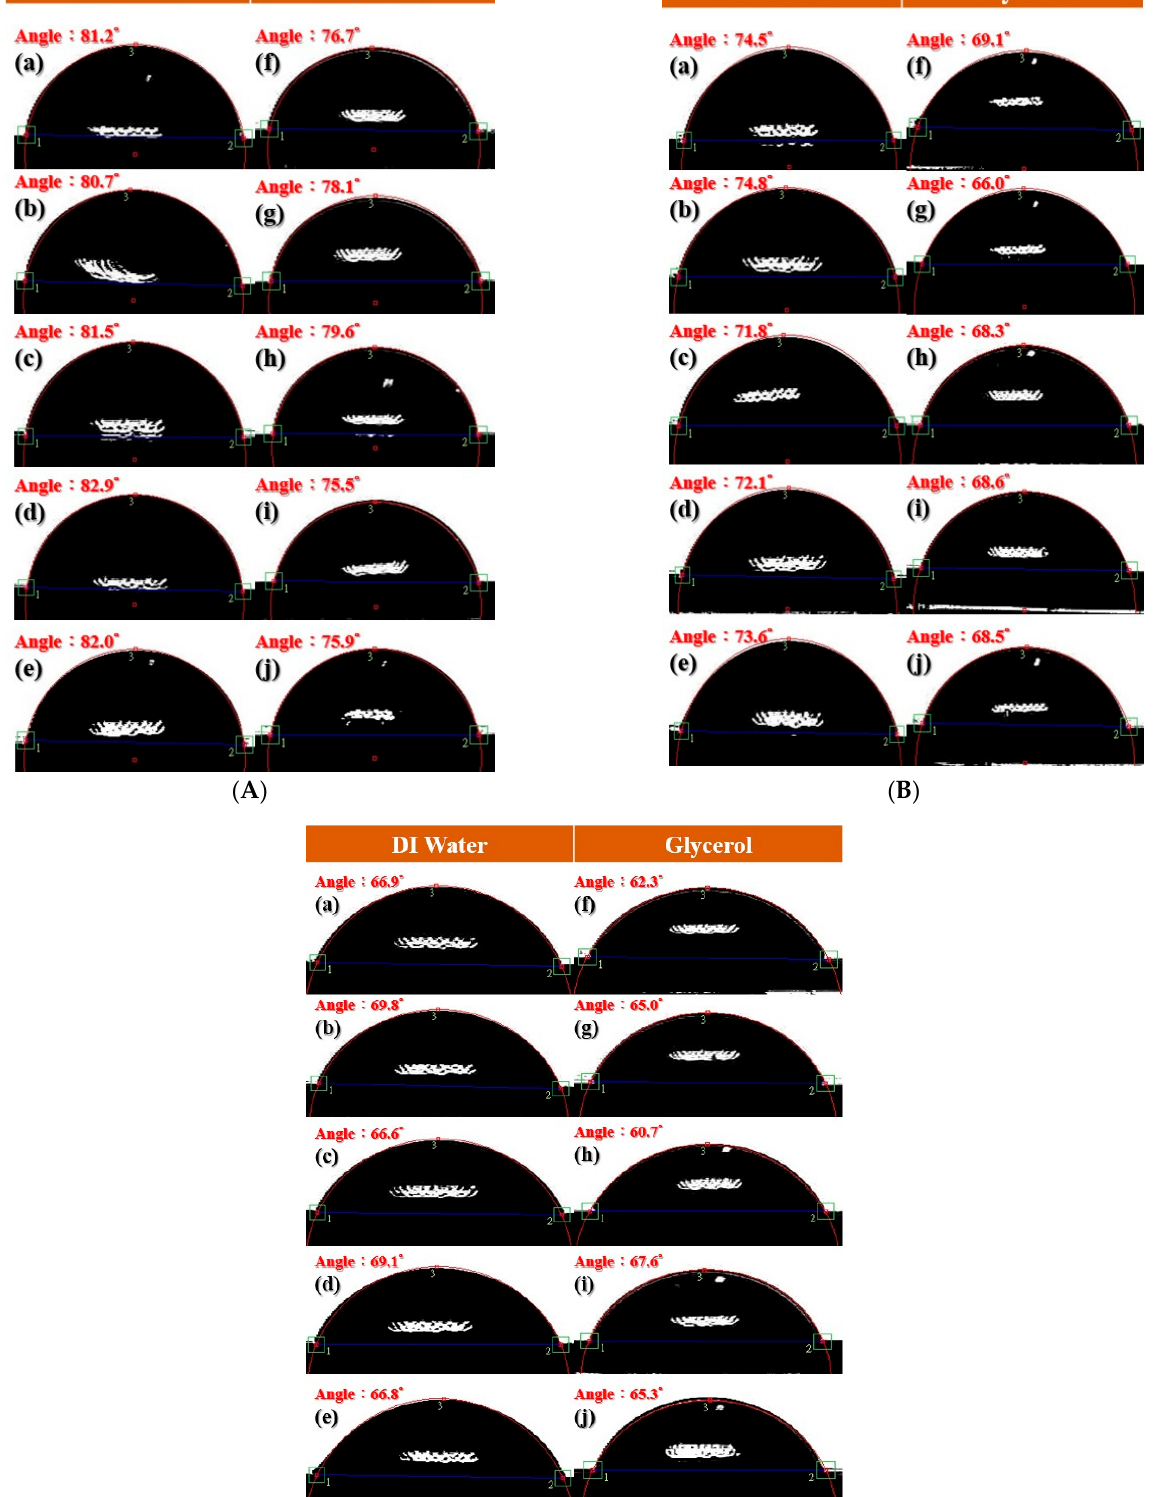
Figure 3. Contact angles of the Co 40 Fe 40 W 20 thin films under three conditions: ( A ) as-deposited, ( B ) after post-annealing at 250 ◦ C, ( C ) after post-annealing at 350 ◦ C with DI water: (a) 10 nm, (b) 20 nm, (c) 30 nm, (d) 40 nm, and (e) 50 nm. Contact angles of the Co 40 Fe 40 W 20 thin films with glycerol: (f) 10 nm, (g) 20 nm, (h) 30 nm, (i) 40 nm, and (j) 50 nm. Table 1. Comparing contact angle, surface energy, and grain size for Co 40 Fe 40 W 20 thin films from different fabrication processes.